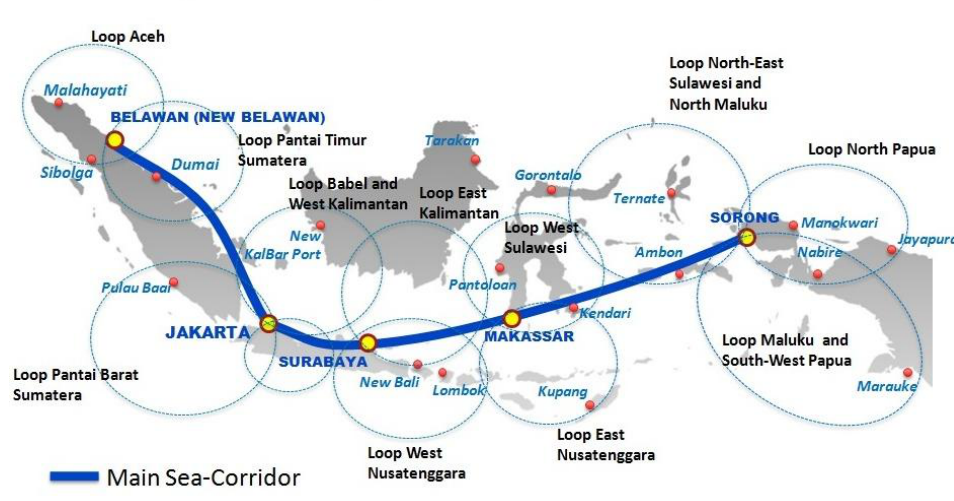
Figure 1. Indonesian Main Sea-Corridor [13].